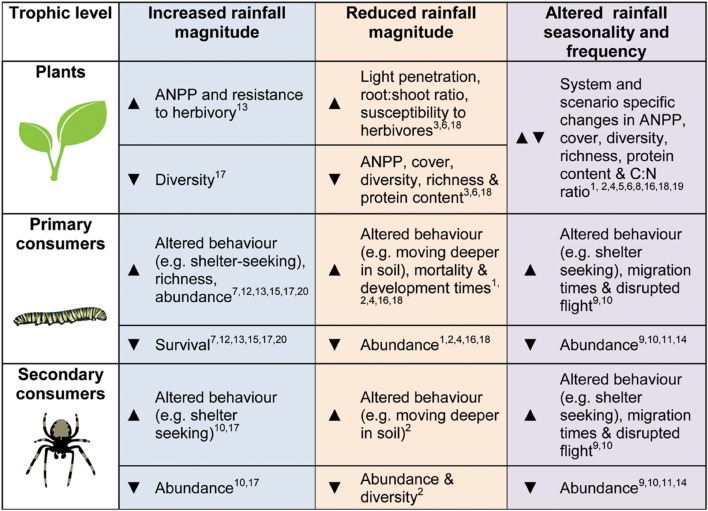
A summary diagram of the general trends expected or found in the literature (theoretical, experimental, and observational studies) for plant, primary consumers (herbivores, detritivores etc.) and secondary consumers (predators and parasitoids), in response to altered precipitation regimes. Arrows:  indicates increases in the given metric,  represents declines and 
 denotes more varied results. References are given by the numbers on the diagram: (1) Barnett and Johnson (2013), (2) Buchholz et al. (2013), (3) Coupe et al. (2009), (4) Davis et al. (2006), (5) Fay et al. (2002), (6) Fay et al. (2003), (7) Guo et al. (2009), (8) Heisler-White et al. (2009), (9) Kasper et al. (2008), (10) Lambeets et al. (2008), (11) Lee et al. (2014), (12) Lenhart et al. (2015), (13) Masters et al. (1998), (14) Palmer (2010), (15) Staley et al. (2007), (16) Staley et al. (2008), (17) Suttle et al. (2007), (18) Walter et al. (2012), (19) Warne et al. (2010), (20) Zhu et al. (2014).